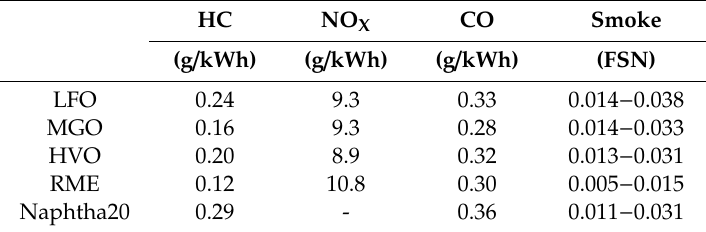
Table 6. Cycle-weighted brake specific emissions of HC, NO X , CO and smoke number ranges from lowest to highest within the non-road steady cycle (NRSC) with di ff erent fuels (Ovaska et al.